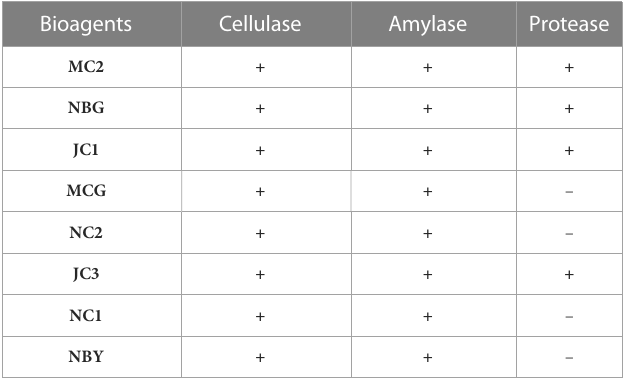
TABLE 6 Activity of the eight promising bioagents to secrete extracellular enzymes.